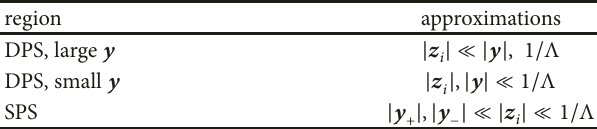
Table 1: Regions of 𝑦 discussed in the text.